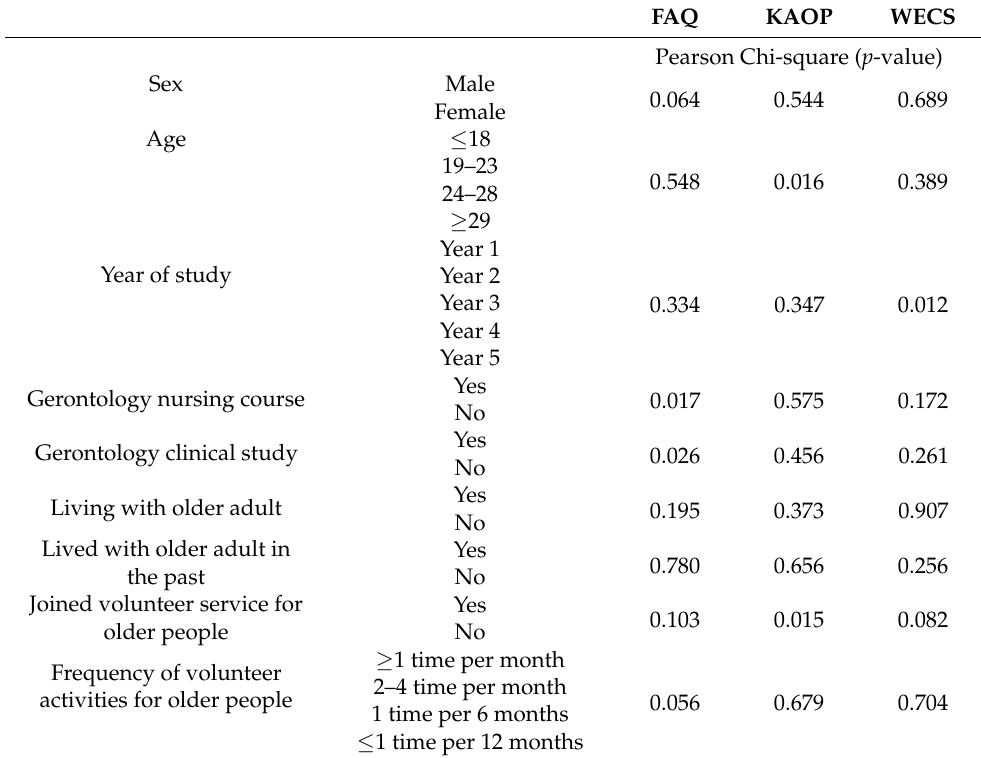
Table 3. Correlation between demographic characteristics and knowledge, attitudes and care willing- ness (N = 139). Sex Male